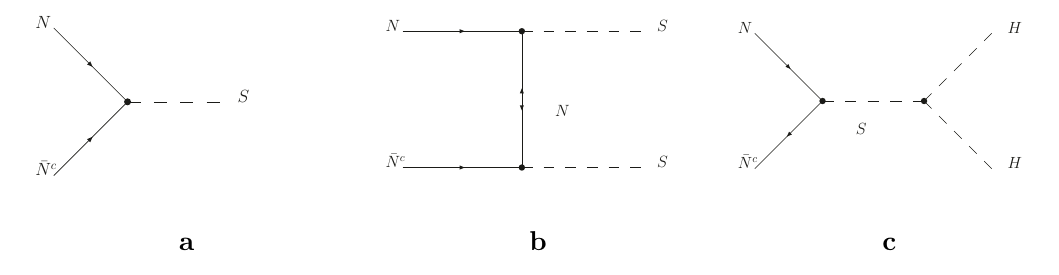
Figure 1. Processes equilibrating N through S